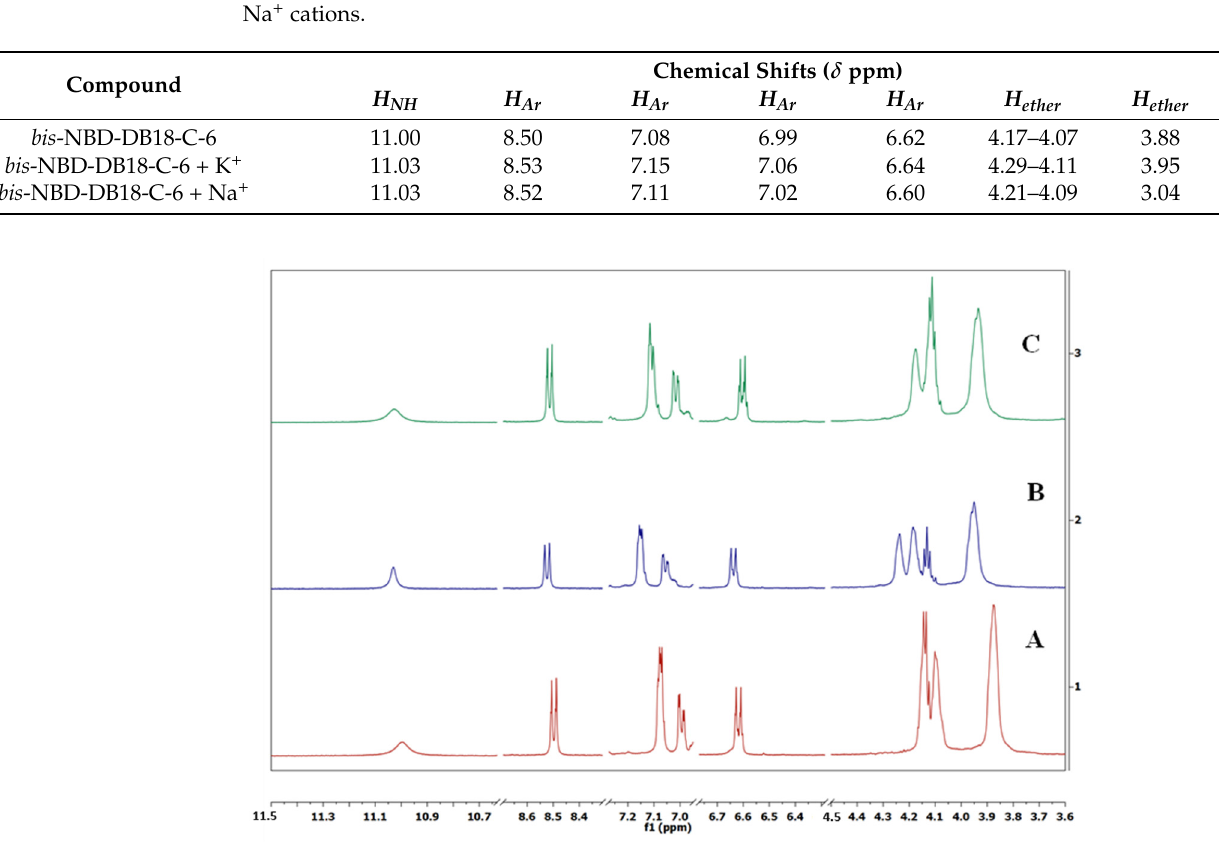
Figure 3. Superposed 1 H-NMR spectra of ( A ) bis- NBD-DB18-C-6, ( B ) bis- NBD-DB18-C-6 + K + , and ( C ) bis- NBD-DB18-C-6 + Na + .